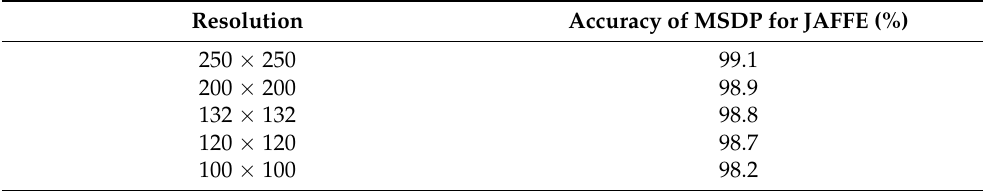
Table 1. Classification accuracy variation at different resolutions of the JAFFE